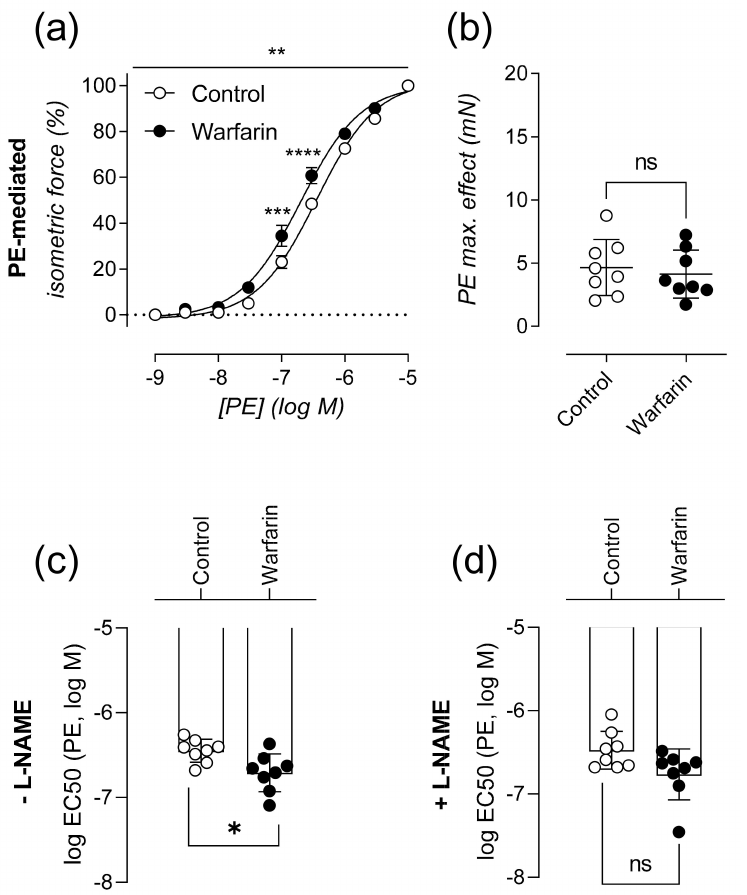
Figure 2. Calcified aortas are significantly more sensitive to α 1-adrenergic stimulated vascular smooth muscle cell contraction. Relative isometric force is shown in relation to increasing concentrations of PE (%) in the absence L-NAME ( a ). Maximal PE mediated contraction (mN) ( b ) and sensitivity to PE, expressed as logEC50 ( c ) in the absence of L-NAME are shown. LogEC50 in the presence of L-NAME ( d ) (Control: n = 8, Warfarin: n = 8). Two-way ANOVA with Sidak multiple comparison correction